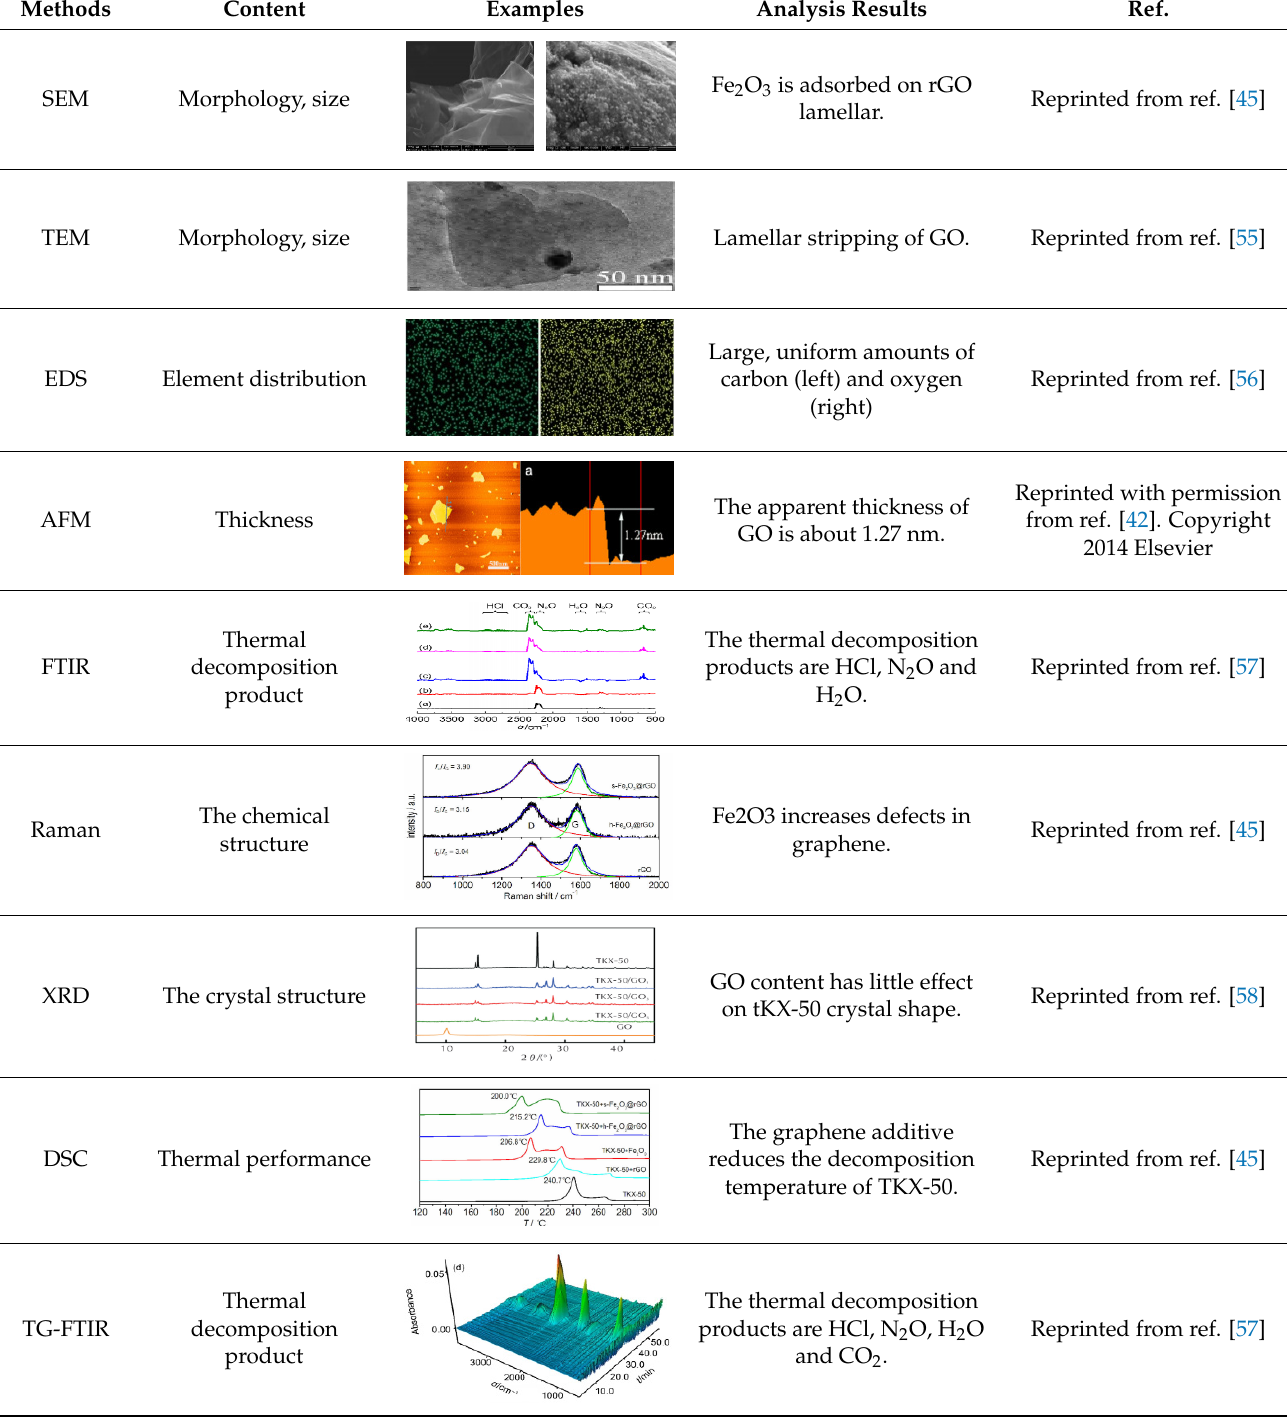
Table 1. Characterization of graphene-based energetic compounds.